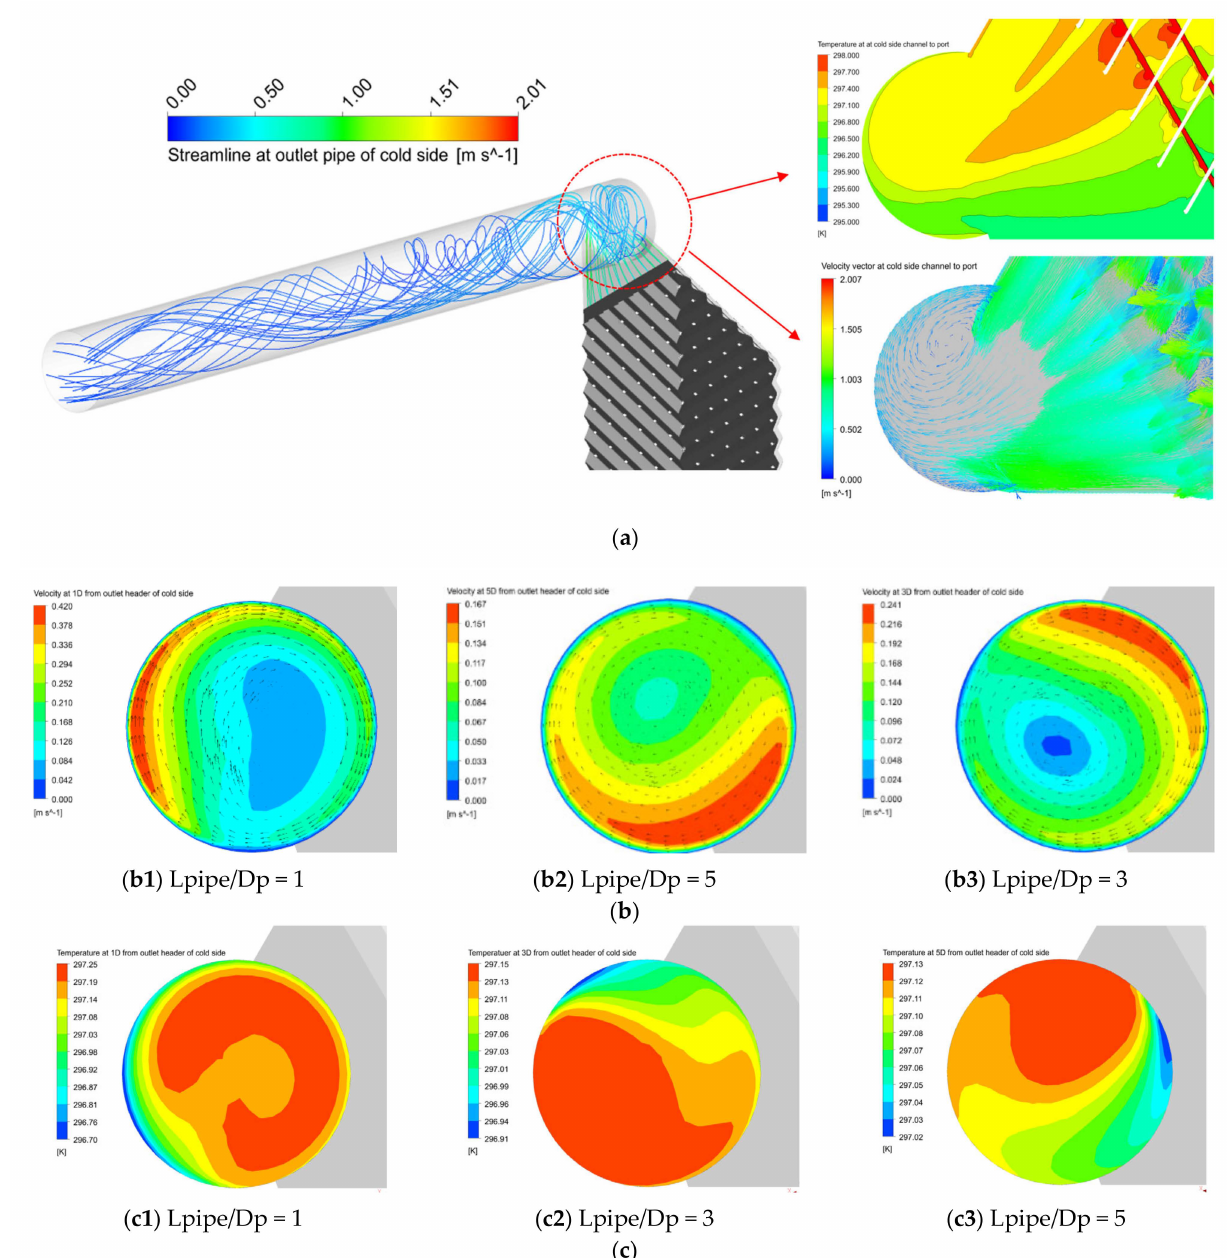
Figure 11. Temperature and velocity distribution image at outlet port and pipe: (a) Streamline at the outlet port of cold side and temperature contour and velocity vector at the outlet port; ( b ) velocity contour and vector at the outlet pipe of the cold side; ( c ) temperature contour at the outlet pipe of the cold